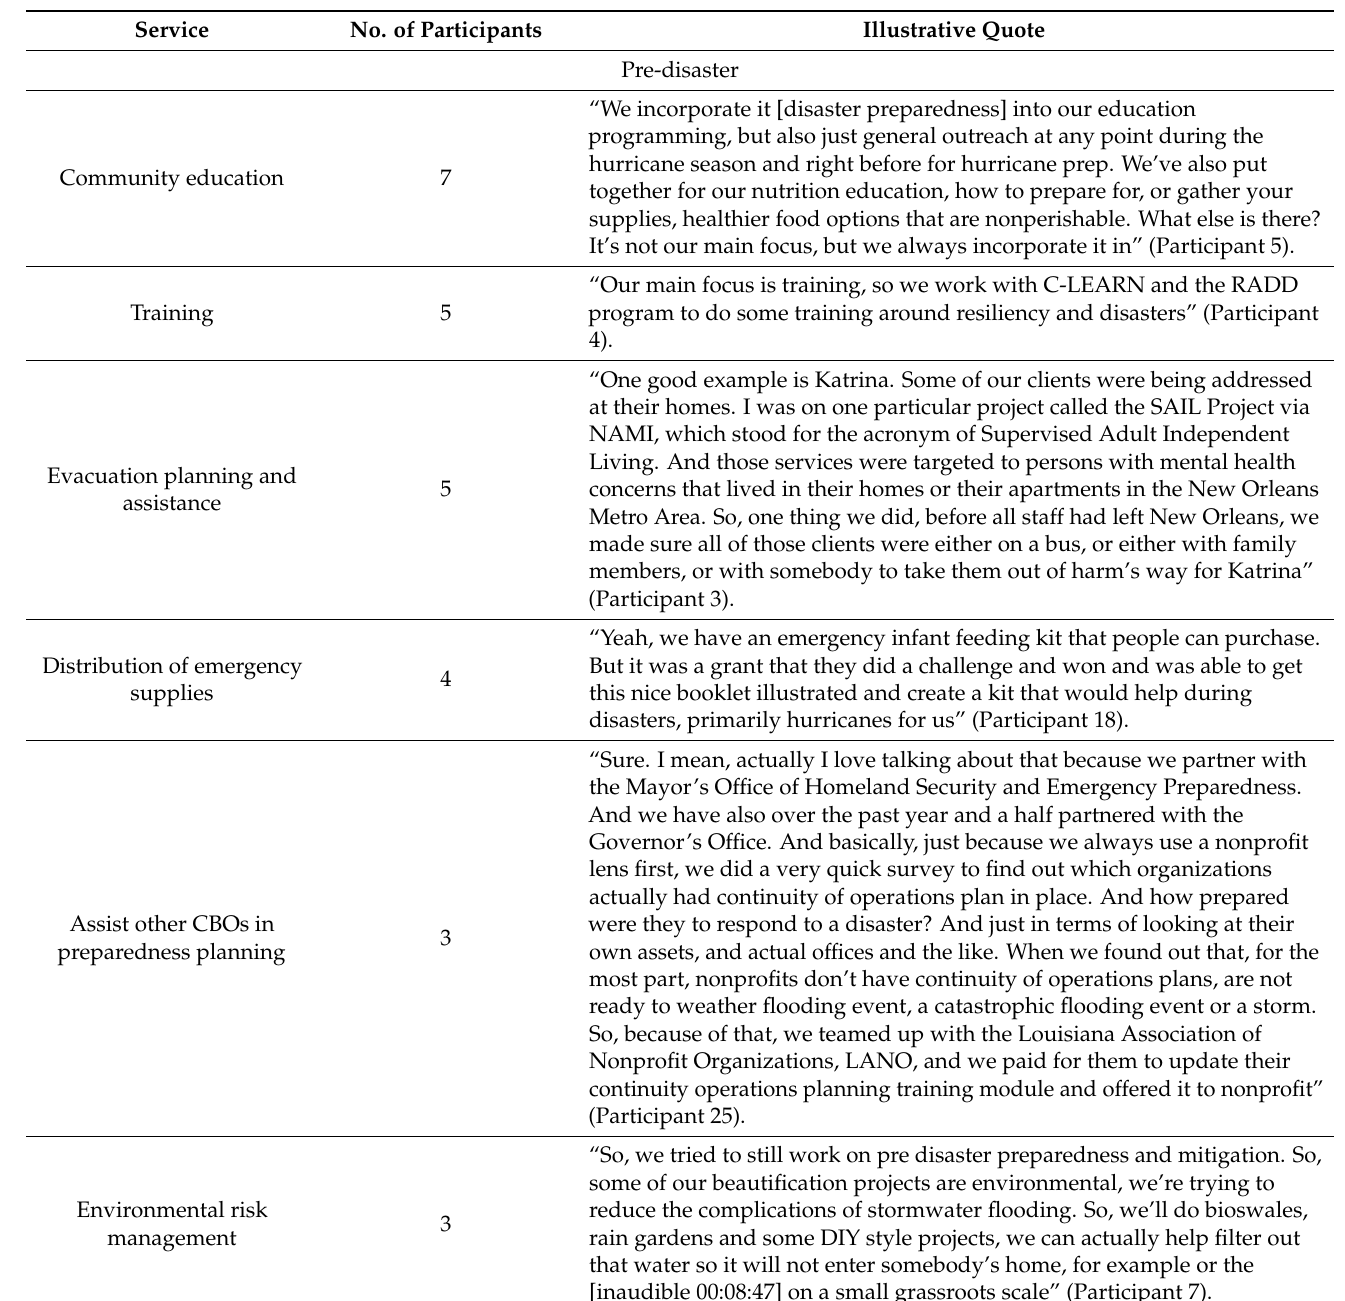
Table 2. Pre-disaster services provided included community education and webinars, training of volunteers and first responders in disaster preparedness and response training, evacuation support (resident registration, development of evacuation plans), assisting other CBOs in preparation and implementation of disaster preparedness plans, distribution of emergency supplies, fundraising and financial support, and environmental risk manage- ment. Post-disaster services provided included material assistance to disaster survivors (food, water, supplies, financial), post-disaster debris removal, delivery of mental health service, rescue and recovery of survivors, emergency health care support, fundraising, and follow up with evacuees. Table 2. Disaster preparedness and response services provided by community-based organizations in southern Louisiana.